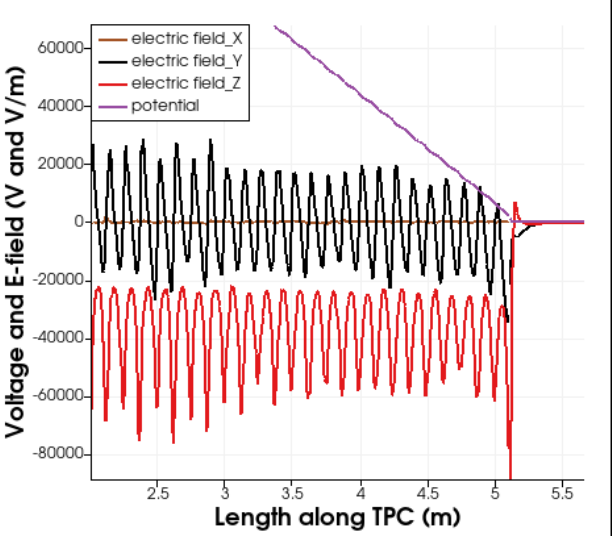
Figure 8. Oscillating non-uniformities in the y and z components of the electric field near the voltage strips.